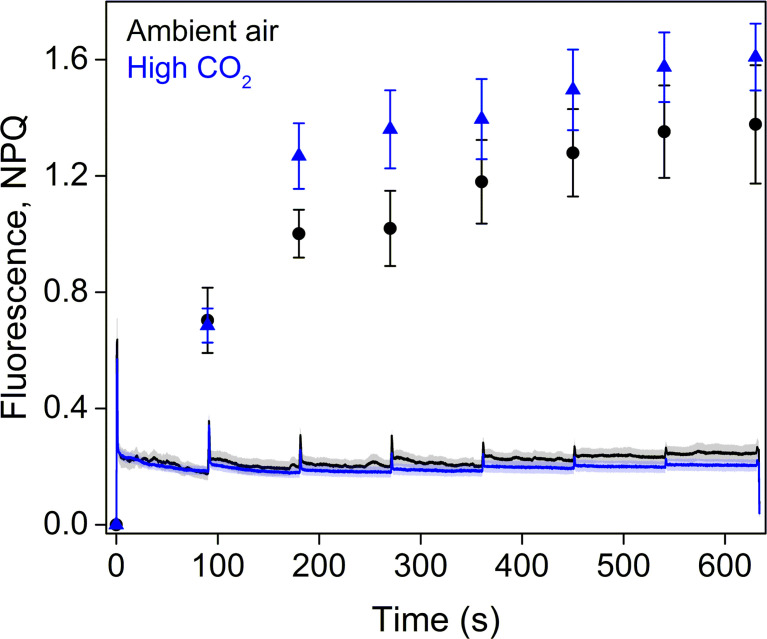
Fluorescence traces and NPQ during the RLC measurement.All light steps of the RLC were continued for 90 s and the PPFDs used were 0, 11, 60, 100, 170, 270, 420, and 600 µmol m−2s−1. The data represent averages of five biological replicates. All error bars and shaded areas around the curves show SE.